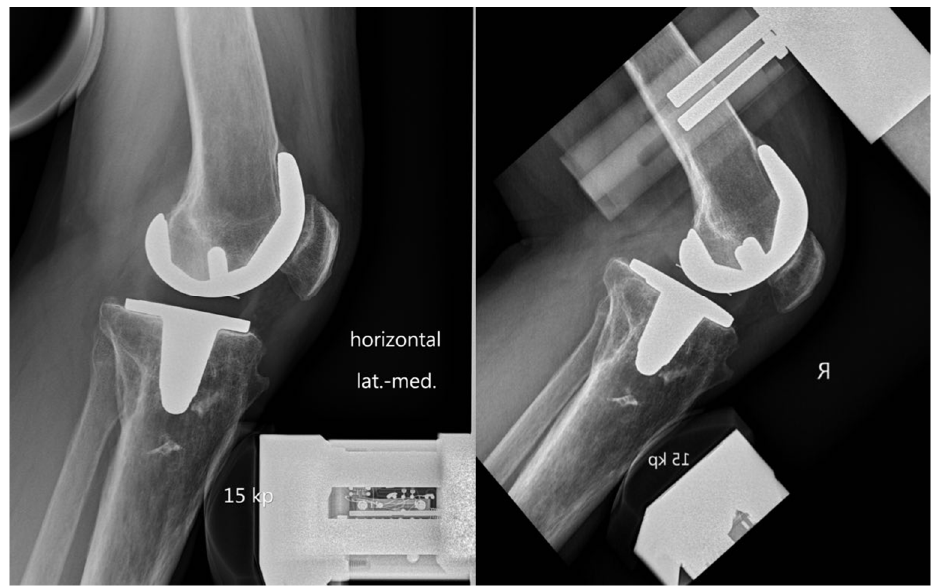
Figure 2. Stress radiographs showed increased posterior translation in posterior drawer position in 90° flexion compared to 30° flexion.